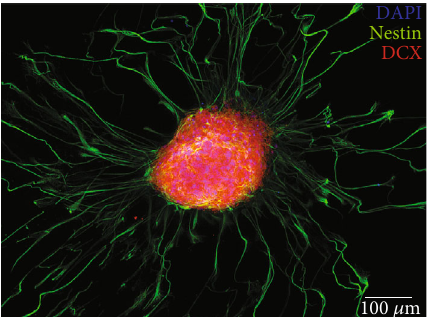
Figure 4: Neurosphere of the IC after 4 days of growth on a glass coverslip. After two days on PDL- and laminin-coated coverslips, these neurospheres showed an outgrowth of sphere branches with an increase in length over the course of time. Nuclei were stained with DAPI (blue). The neural progenitor cell marker Nestin (green) was positive in cells inside the sphere and in the branches. Progenitor cells within the neurospheres were stained positive for the neuronal migration protein doublecortin (DCX)